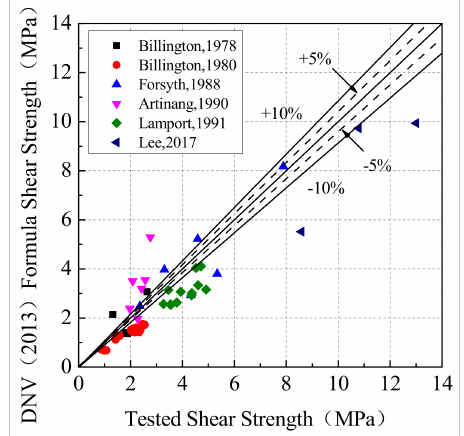
Figure 16. Comparison of shear strength calculated using DNV and tested results.